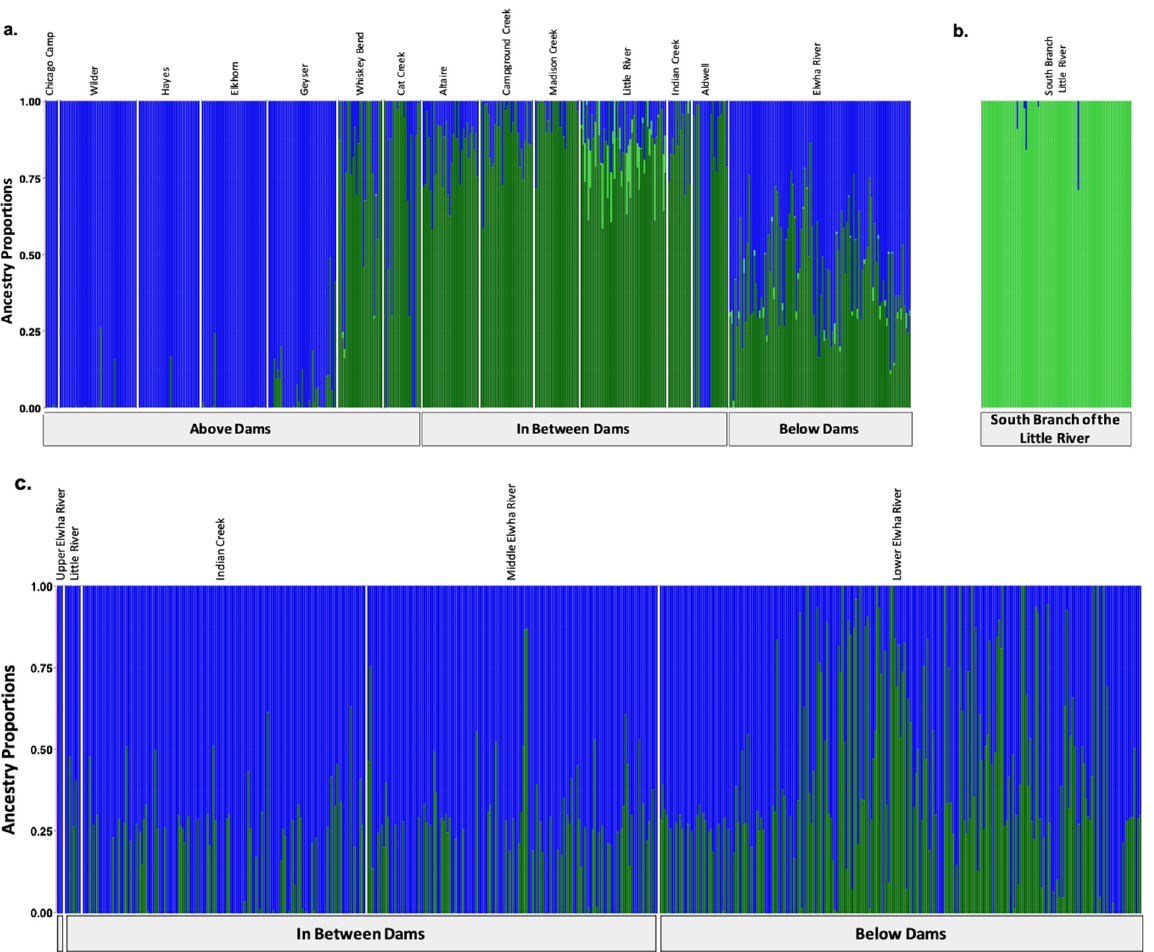
Figure 3. Population assignments computed by fastSTRUCTURE for samples collected ( a , b ) prior to dam removal supported three distinct genetic clusters (K = 3). ( a ) High levels of genetic structure were observed among populations split by man-made barriers such as dams ( b ) as well as natural barriers, such as the waterfalls that separate the South Branch of the Little River from the Little River. ( c ) Post-dam removal, we detected two genetic clusters with increasing levels of admixture. Each colored vertical bar represents a single individual sampled at one of the sampling sites labelled across the top x axis, organized from up-river to down-river and divided by anadromous barrier location, as labelled on the bottom x axis. The left-most samples in the plot, denoted by an unlabeled, empty gray box, include samples from above the dams, furthest up-river. Each color represents a distinct genetic cluster.